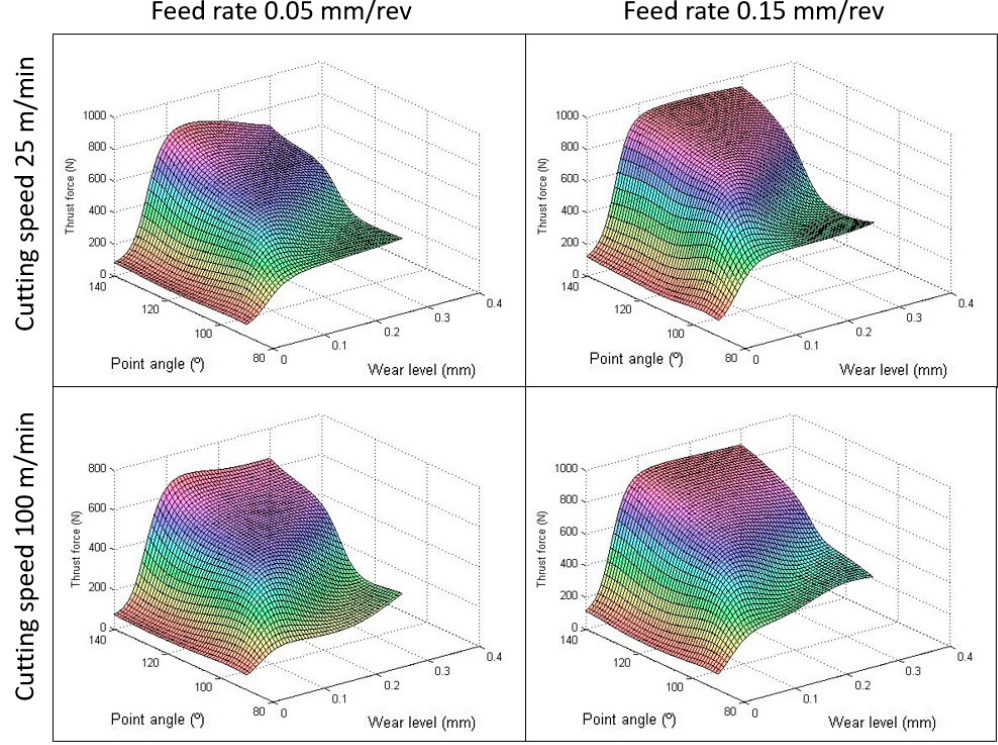
Figure 8. Interaction effects of the point angle and wear level on thrust force.